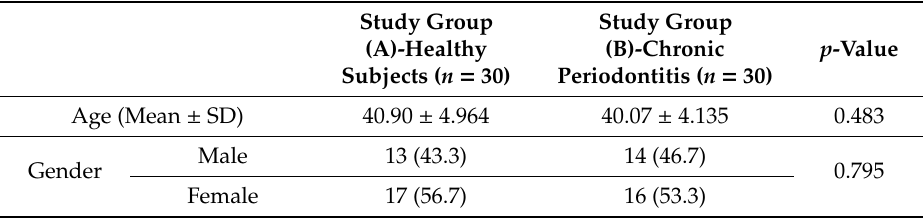
Figure 1. Consort flowchart. Table 1. Descriptive analysis for sample characteristics.